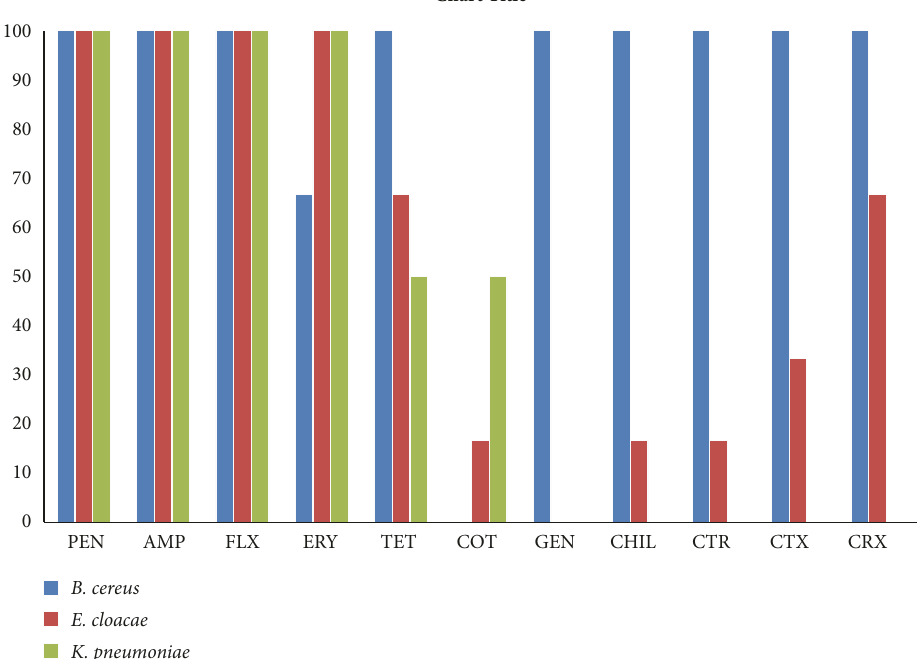
Figure 1: R e s i s ta nc e of i d e n ti fi e d i so late s t o a n ti m i c r ob ial a g e n t s. PEN= Penicillin, AMP= Ampicillin, FLX= Flucloxacillin, ERY= Ery- thromycin, TET=Tetracycline, COT= Cotrimoxazole, GEN=Gentamicin, CHL=Chloramphenicol,, CTR= Ceftriaxone, CTX= Cefotaxime, and CRX=